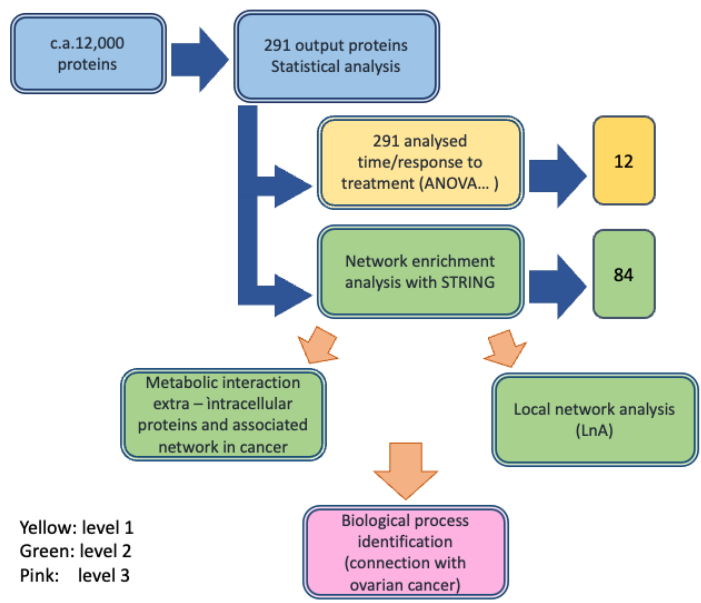
Figure 1. Workflow of the protein identification process in ovarian cancer serum samples performed through label free differential mass spectrometry analysis and integration with the bioinformatic analysis.